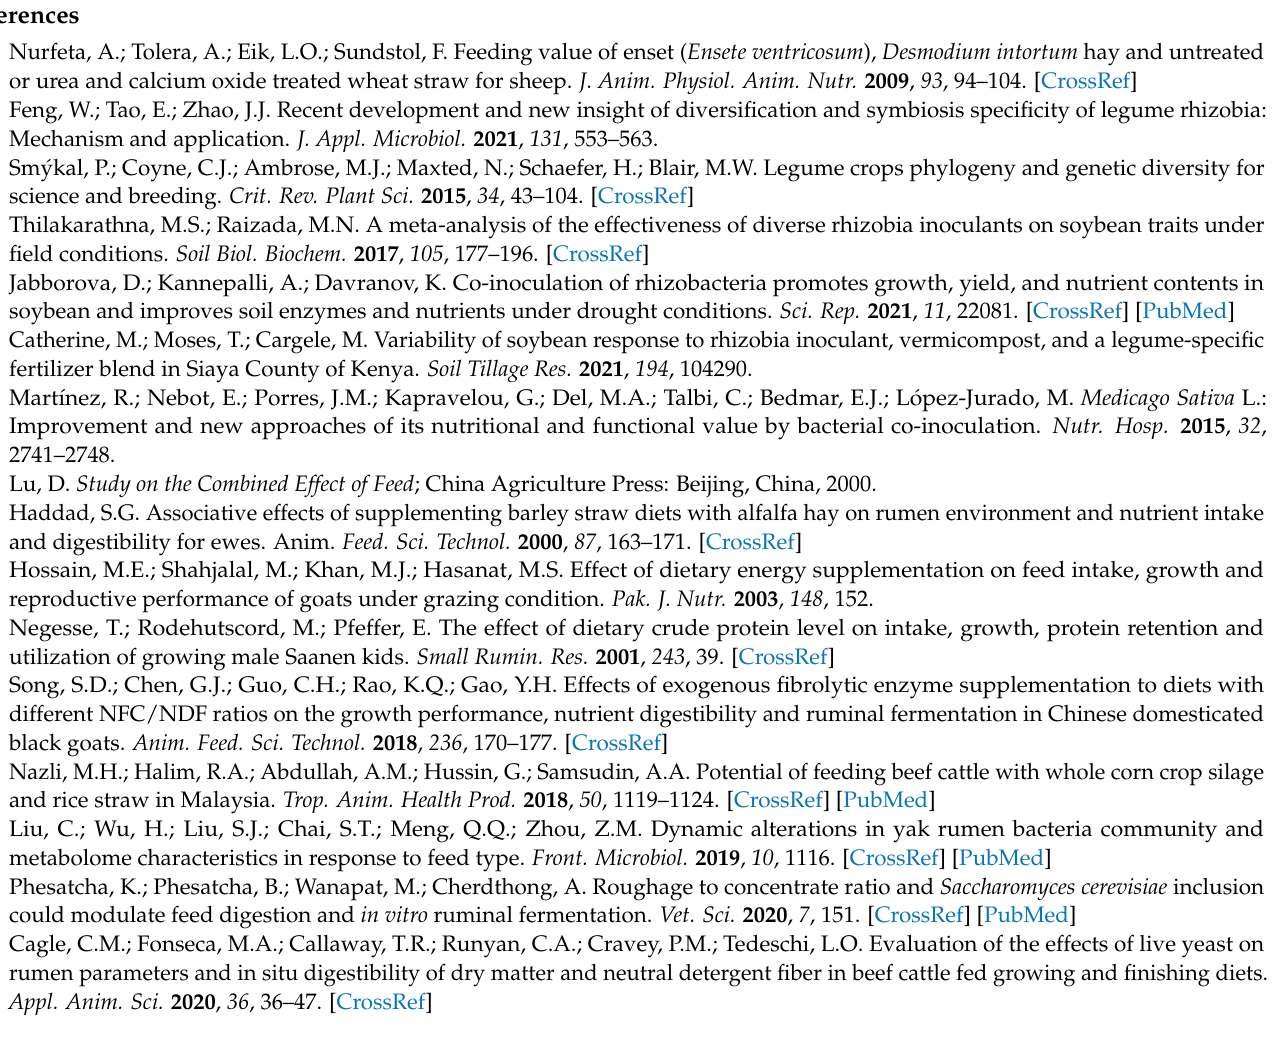
Table S2. Principal Factor Loading Matrix. Table S3. In vitro fermentation gas